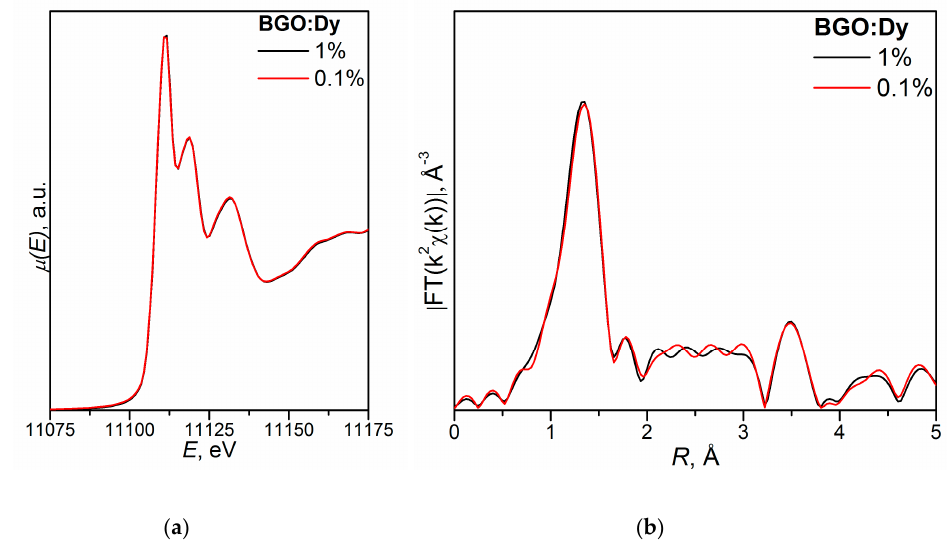
Figure 12. Ge K-edge ( a ) XANES spectra and ( b ) EXAFS Fourier transforms ( k -range, 2–13 Å − 1 ) for the BGO:1.0Dy and BGO:0.1Dy samples.